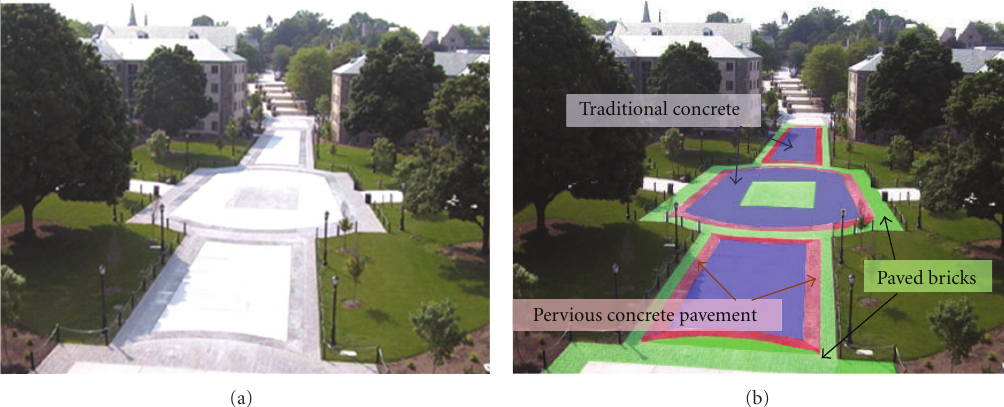
Figure 1: (a) Aerial view of Villanova Campus Pervious Concrete Site in 2003. (b) pervious concrete (red), traditional concrete (purple), and paved brick (green) surfaces